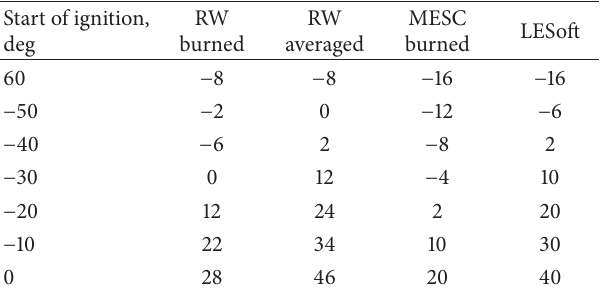
Table 7: Location of temperature peak predicted with various